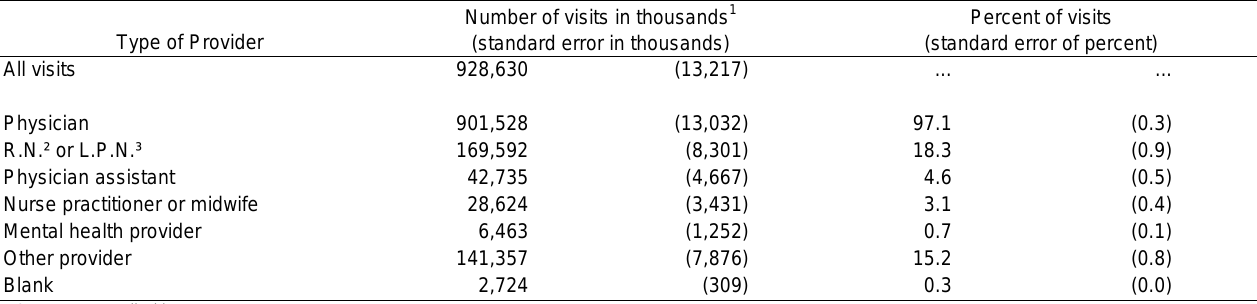
...Category not applicable. 1 Combined total of individual providers exceeds "all visits" and "percent of visits" exceeds 100%, because more than one provider may be reported per visit. The sample of visits was drawn from all scheduled visits to a sampled physician during the 1-week reporting period. However, at 2.9 percent of these visits, the physician was not seen; instead, the patient saw another provider. In addition, at many visits, patients were seen by multiple providers, the most common being a physician and an R.N. or L.P.N. 2 R.N. is registered